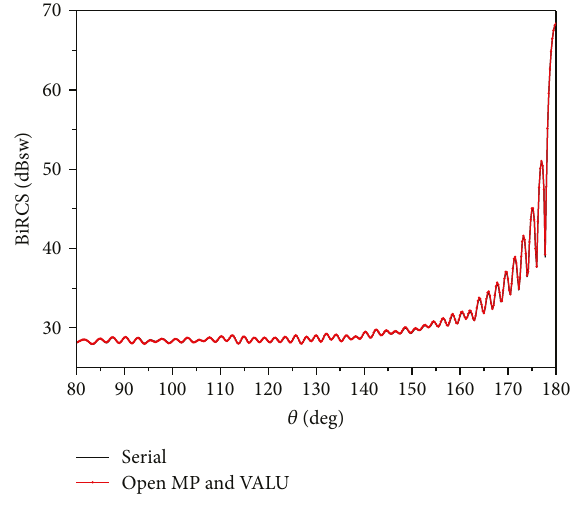
Figure 2: BiRCS of a coated sphere with SE-MLFMA by using the serial and hybrid-parallel